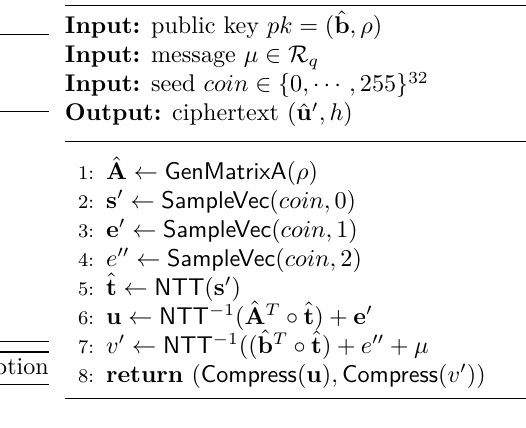
Algorithm 4 Kyber.CPAPKE